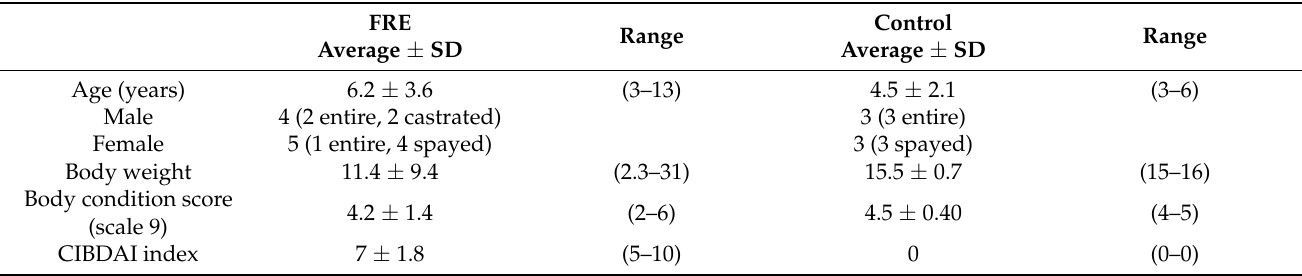
Table 1. Data of signalment and CIBDAI (canine inflammatory bowel disease activity index) in dogs with FRE (food-responsive enteropathy) and healthy dogs included in the